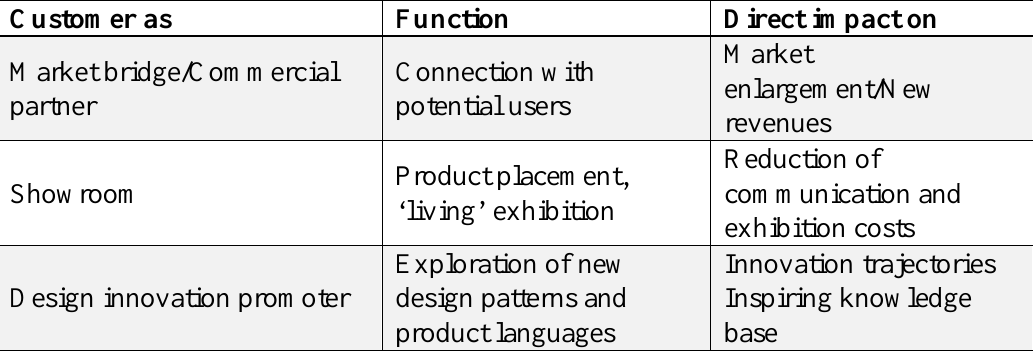
Table 2: The three Roles played by the Customer in Lago Business Model Customer as Market